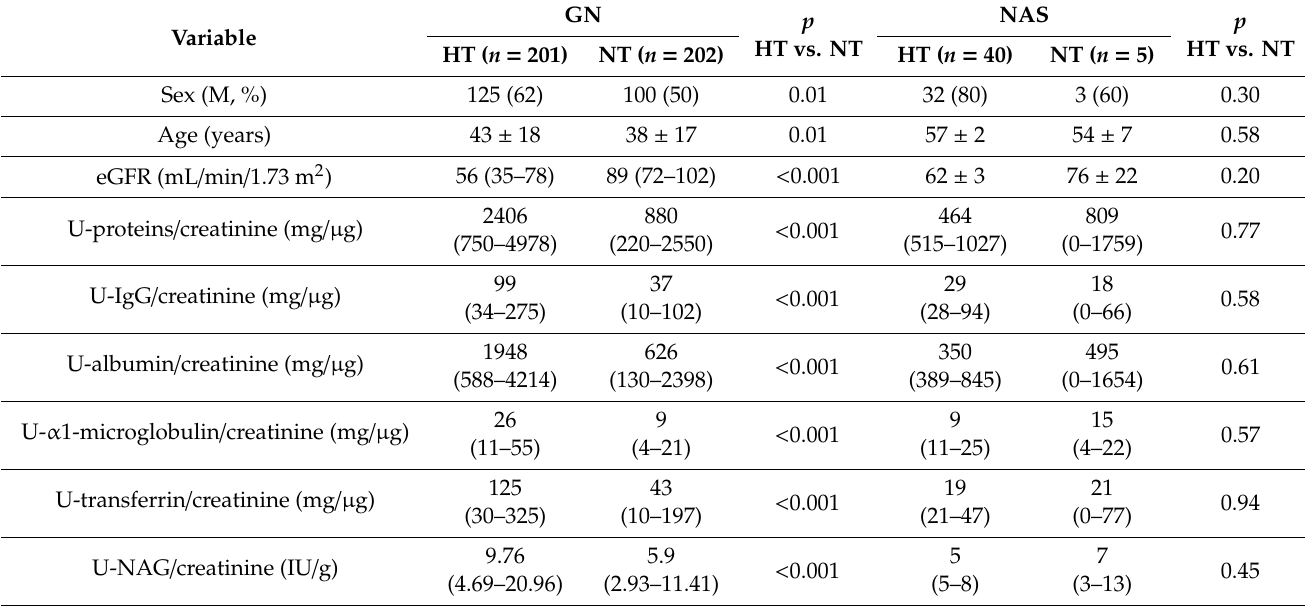
Table 2. Renal function in GN and NAS patients with / without arterial